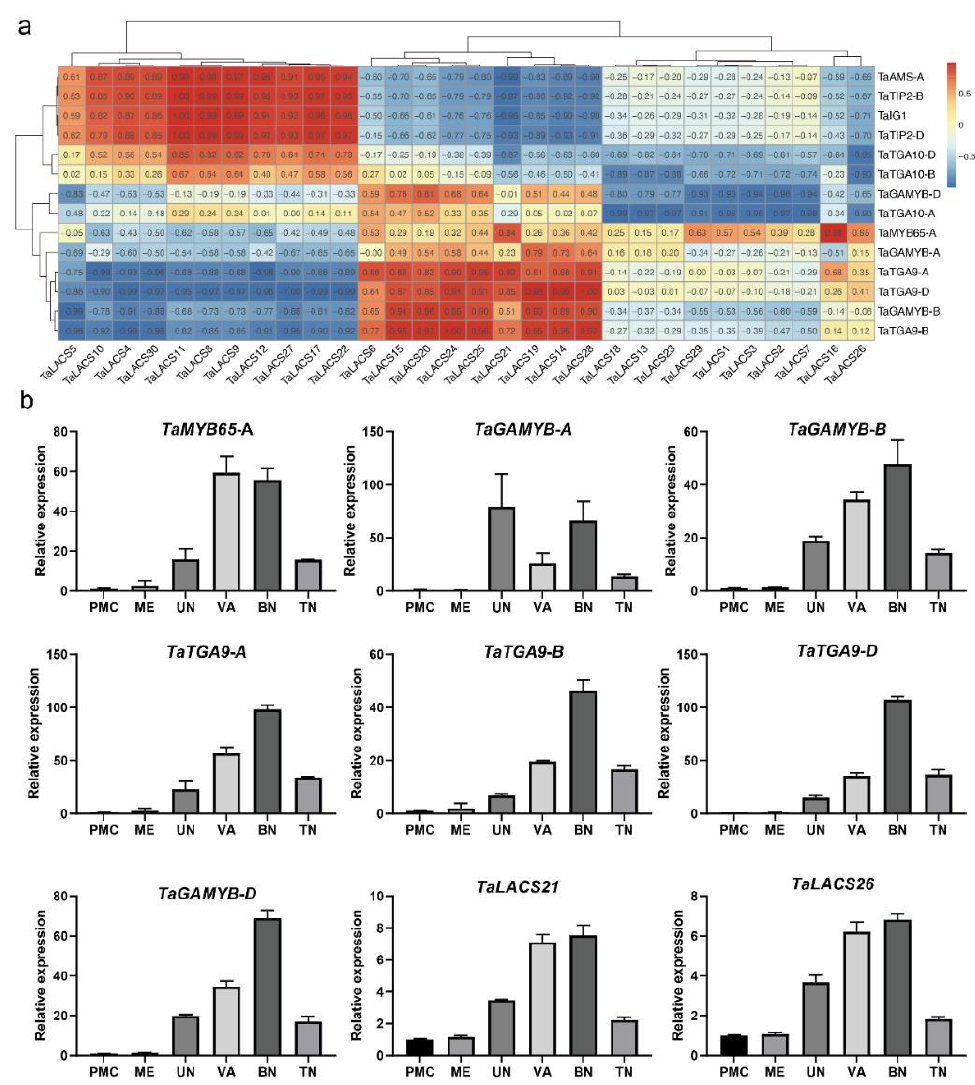
Figure 6. Expression correlation analysis among TaLACS genes and transcription factors in wheat anther. ( a ) Expression correlation analysis among TaLACS genes and transcription factors. Red indicates positive correlation; blue indicates negative correlation. Pearson correlation coefficients between genes were shown in the boxes of heatmap. ( b ) Expression analysis of selected transcription factors and TaLACS in wheat anthers.